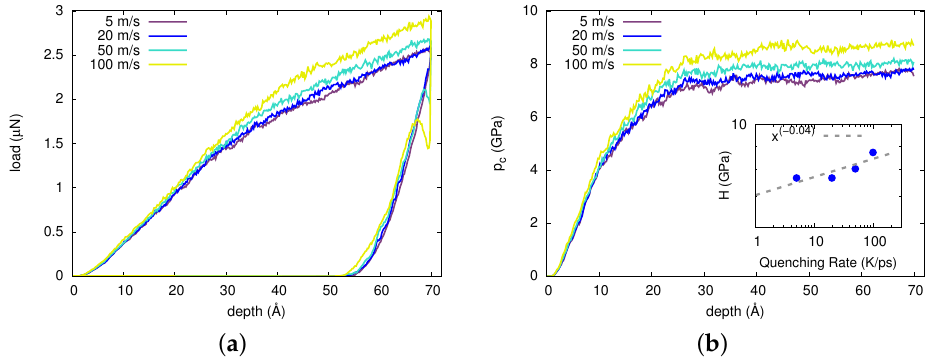
Figure 5. ( a ) Indentation load vs. indentation depth for different indentation rates; all data taken at 10 K. ( b ) Contact pressure as a function of indentation depth for indentation rates shown in ( a ). Inset: Averaged hardness against indentation rate fitted to a power law with exponent ∼